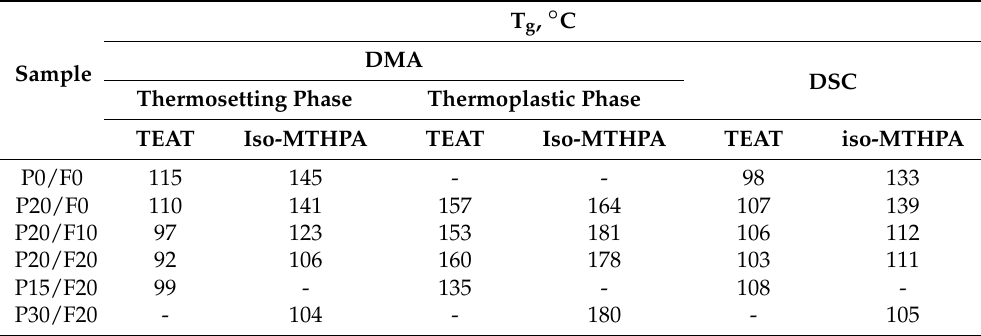
Table 2. Glass transition T g temperatures of epoxy matrices modified with PSU and FGE obtained by DMA and DSC